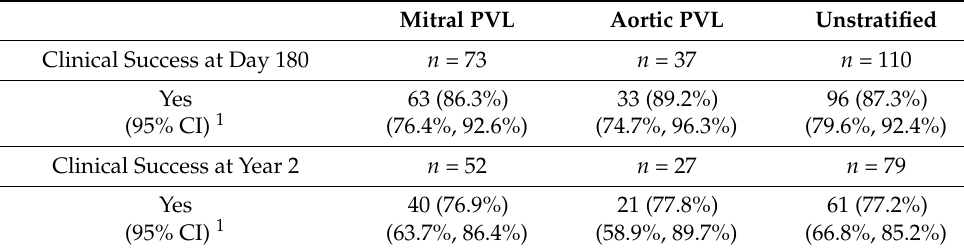
Table 4. Clinical success (FAS).